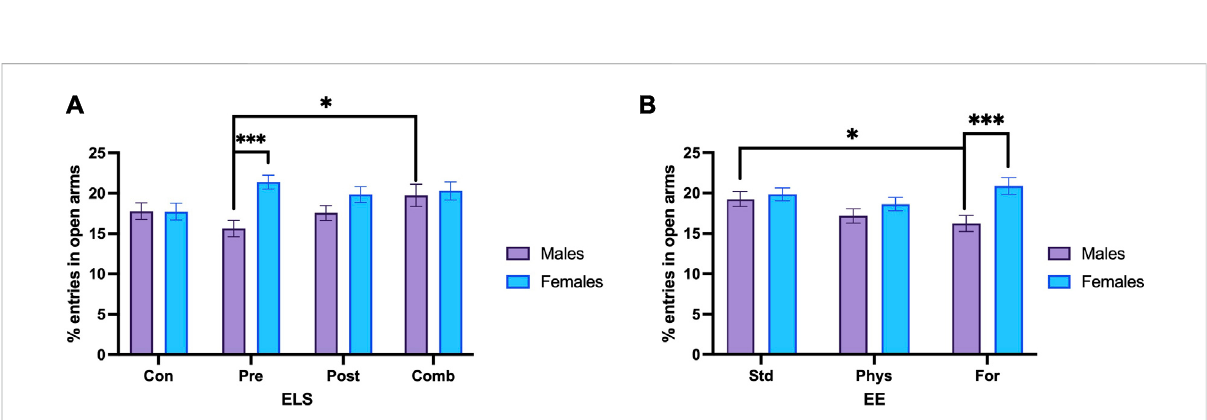
FIGURE 5 Percentage of open armentries. (A) Males exposed to combined ELS(n = 25) enteredmore times to the openarm comparedto males exposed toprenatalELS(n=31).Femalesexposedtoprenatalstress(n=28)enteredmoretimestotheopenarmcomparedtomalesunderthesameprenatal stress condition (n = 31). (B) Males with standard housing (n = 39) increased the open arm entries, compared to males housed with Foraging-EE (n = 38). Females housed with Foraging-EE (n = 37) showed increased open arm entries compared to males housed with Foraging-EE (n = 38). Abbreviations: ELS, Early life stress; Con, Control; Pre, Prenatal; Post, Postnatal; Comb, Combined; EE: Std, Standard; Phys, Physical-EE; For, Foraging-EE. Three Way ANOVA (see Table 1 for statistical results): *** p < 0.001, * p < 0.05.